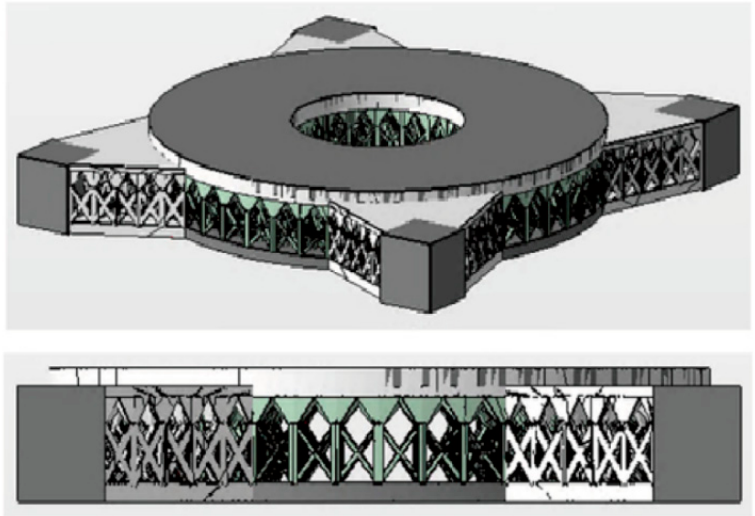
Figure 26. The complete mirror from different views